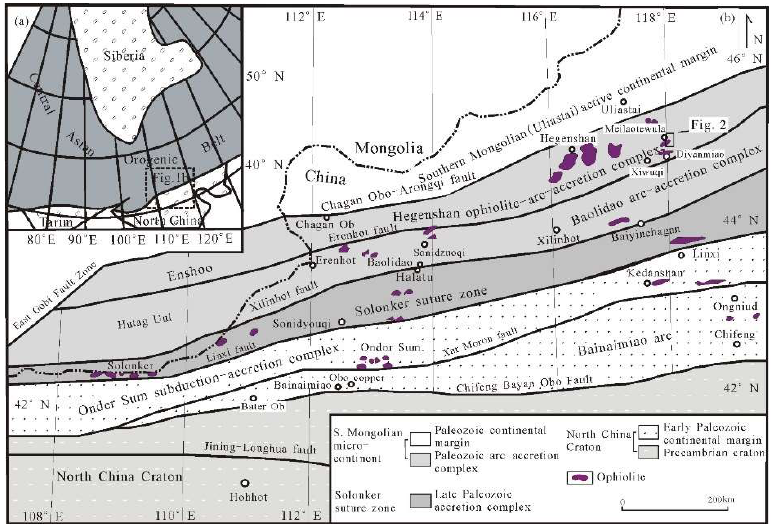
Figure 1. ( a ) Tectonic framework of the North China–Mongolia segment of the Central Asian Orogenic Belt [16]. ( b ) Geological sketch map of the northern China–Mongolia tract [17,18].